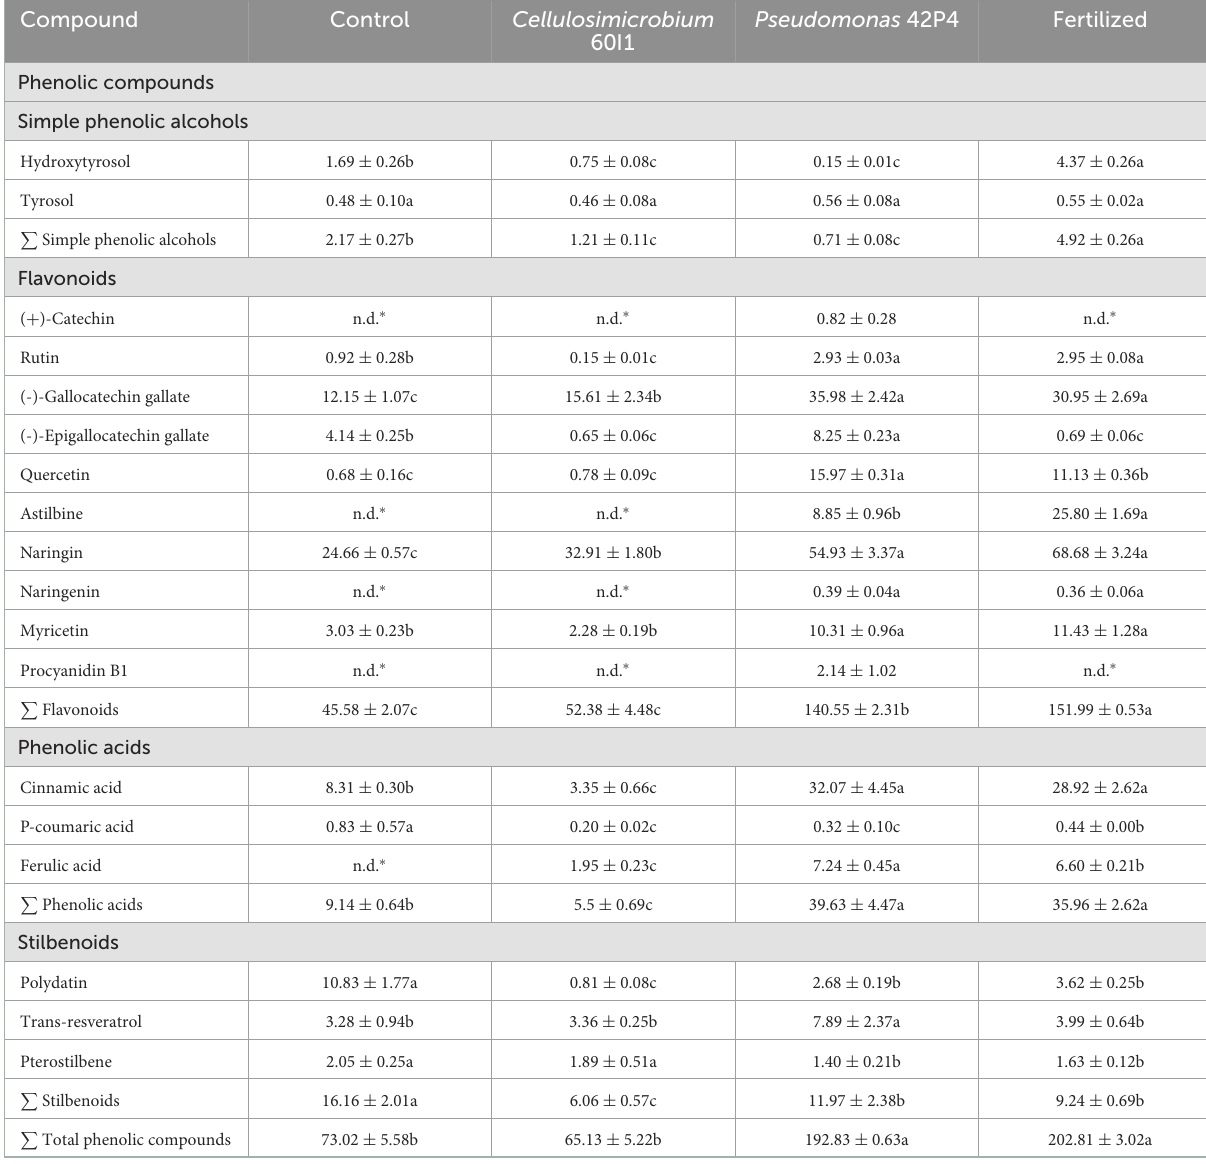
TABLE 3 Phenolic compounds quantified in pepper leaves of plants subjected to different